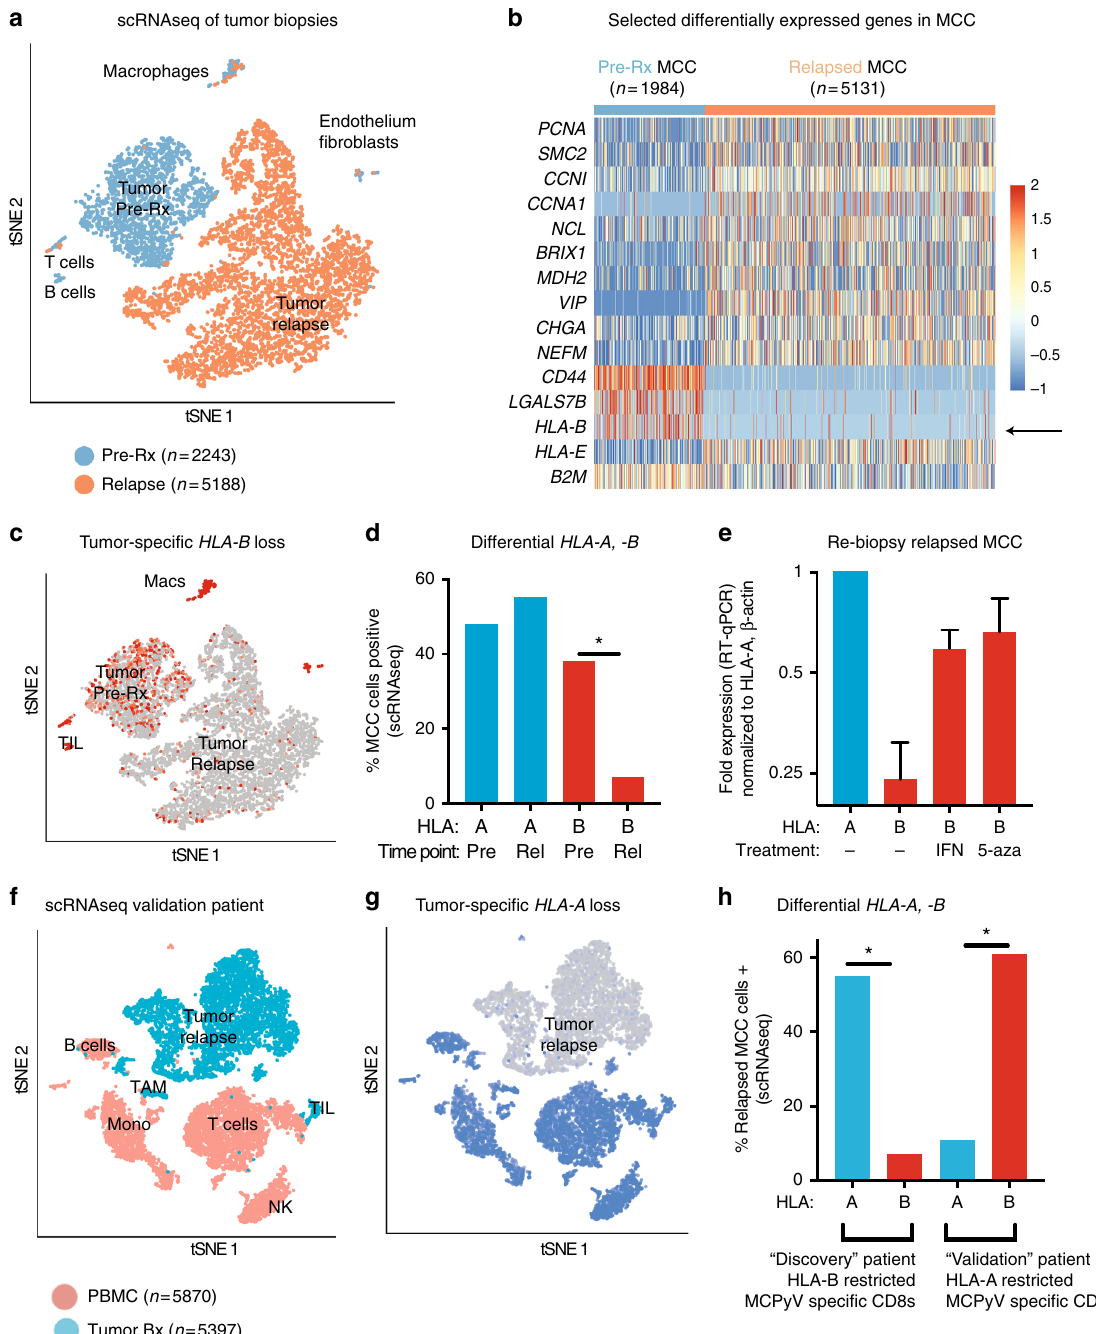
Fig. 4 scRNAseq of tumor biopsies. a – e Discovery patient (2586-4). f , g Validation patient (9245-3). h Both patients. a tSNE of viably frozen cells (n = 7431) from tumor biopsies obtained pre-treatment (blue) and at late relapse/acquired resistance (day + 615; orange). Marked spatial separation of tumor cells from the two timepoints indicates substantial transcriptional change. b Heat map of selected signi fi cantly differentially expressed genes (DEGs) in tumor clusters. For full table of DEGs, see Supplementary Data 2. c tSNE of HLA-B expression. d Differential change in scRNAseq expression of HLA-A, -B by tumor cells. HLA (HLA-A, HLA-B) and time point (pre: pre-treatment, rel: acquired resistance/relapse) are indicated below. e qPCR validation and reversibility of HLA-B downregulation on a repeat tumor biopsy at time of acquired resistance, day + 832, graphed on a log2 scale. Tumor cells were cultured ex vivo for 48 h before RNA collection with either vehicle control ( – ), interferon gamma (1000 IU/mL; IFN) or the hypomethylating agent 5- azacytidine (1 μ M; 5-aza) as indicated below. Bars represent mean and error bars represent range of two experimental runs, each performed with triplicate wells. f tSNE of specimens from late relapse in the validation patient (day + 565 post treatment). Viably frozen cells ( n = 11267) from PBMC (pink) and (Supplemental Figures 10 and 11). g tSNE of HLA-A expression. h Differential expression of targeted and non-targeted HLA on relapsed tumor for both patients. Proportion MCC cells expressing gene by scRNAseq are indicated. Data for discovery patient (2586-4) are reproduced from panel 4d for clarity. Please see Methods section for details of scRNAseq biostatistical analysis and determination of